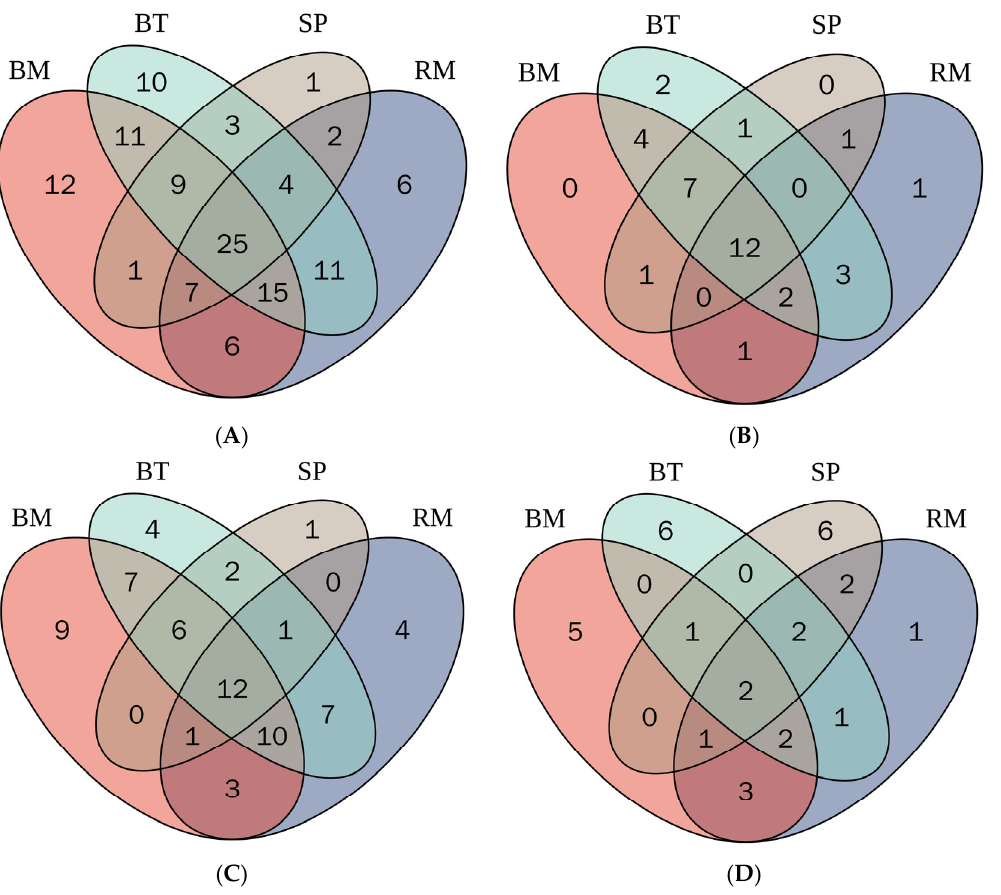
Figure 2. Distribution of phenolic compounds in native Australian river mint (RM), bush mint (BM), bush tomatoes (BT), and sea parsley (SP). ( A ) Total phenolic compounds; ( B ) total phenolic acids; ( C ) total flavonoids; ( D ) total other compounds in native Australian plants.